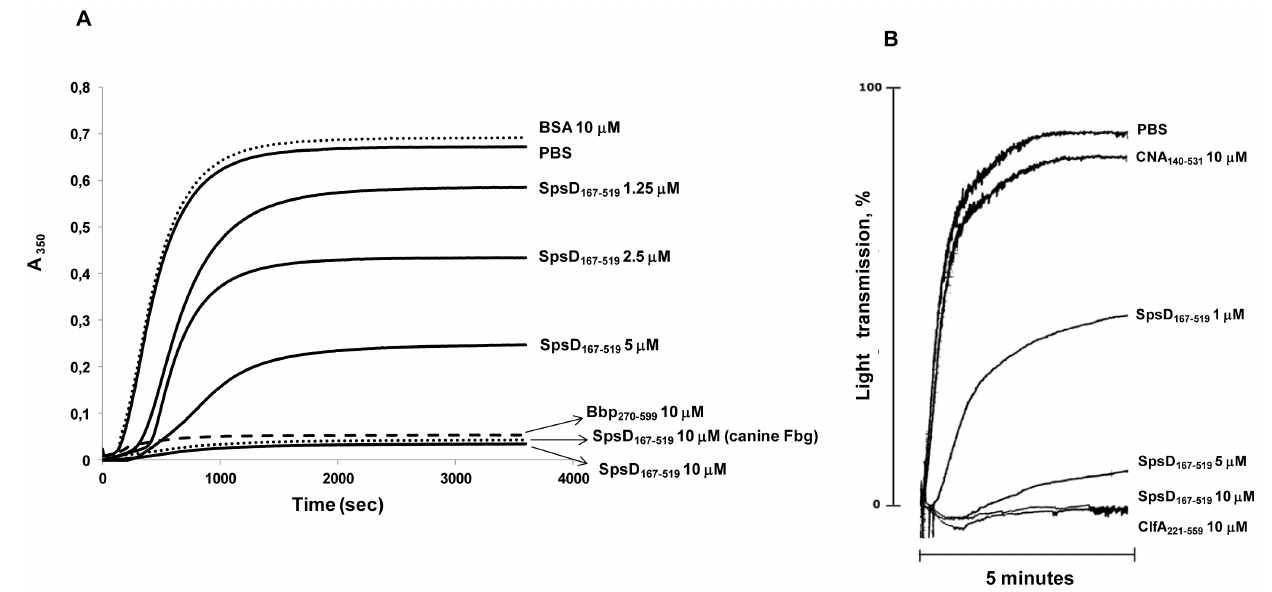
Figure 5. SpsD interferes with Fbg biological activities. (A), SpsD protein inhibits fibrin clot formation. Increasing amounts (1.25–10 m M) of SpsD 167–519 were preincubated with human Fbg prior to the addition of a -thrombin. Polymer formation was measured as a change in turbidity at 350 nm with time. The action of 10 m M Bbp 270–599 and BSA are shown as a positive and negative controls, respectively. The effect of 10 m M SpsD 167– 519 on canine fibrin clot formation is also reported. (B), SpsD protein inhibits ADP-induced platelet aggregation. Washed human platelets (9 6 10 were preincubated in an aggregometer with the indicated concentrations of SpsD 167–519 , ClfA 40–560 and CNA 30–531 in the presence of 200 m g/ml Fbg and 1 mM CaCl 2 at 37 u C for 5 min and then added with 10 m M ADP. Platelet aggregation is expressed as the percentage of light transmission. The experiments have been repeated at least three times with similar